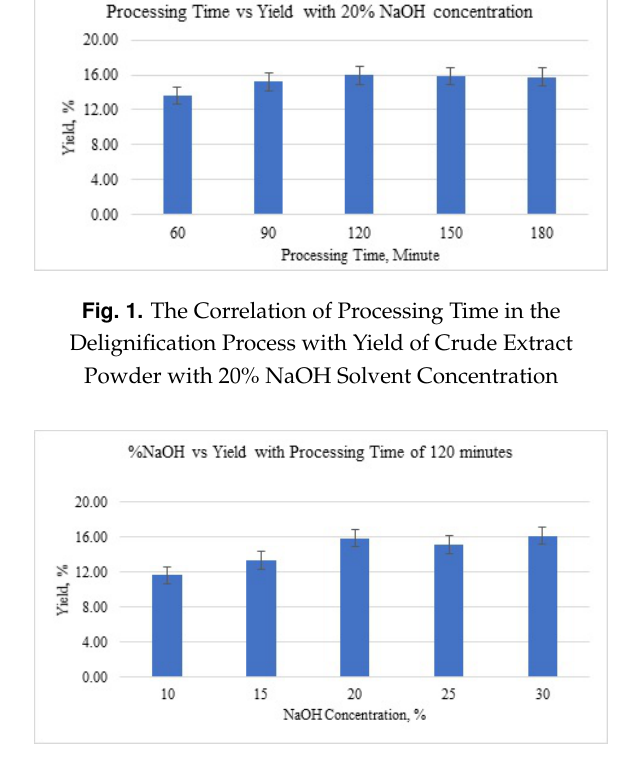
Fig. 2. The Correlation of Processing Time in the Delignification Process with Lignin Content in Crude Extract Powder with 20% NaOH Solvent